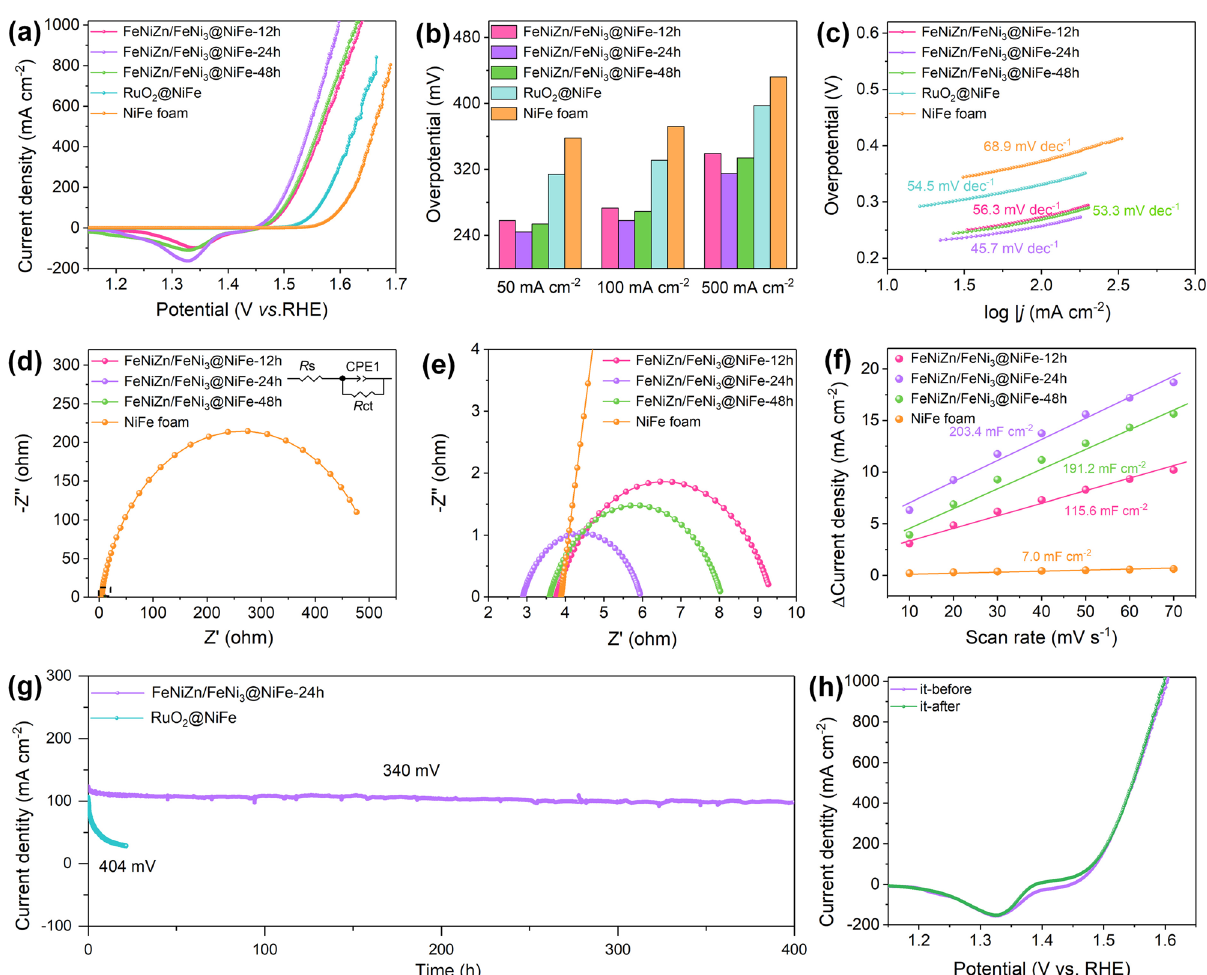
Fig. 5 a LSV curves of FeNiZn/FeNi 3 @NiFe samples, RuO 2 @NiFe, and NiFe foam in 1.0 M KOH solution at the scan rate of 5 mV s −1 . b Overpotentials of all electrodes at the 50, 100, and 500 mA cm −2 . c Tafel plots of all samples. d , e EIS data of FeNiZn/FeNi 3 @NiFe samples and NiFe foam. f The capacitive current at 1.05 V vs. RHE at different scan rates. g i–t curve under the overpotential of 340 and 404 mV for FeNiZn/ FeNi 3 @NiFe-24 h and RuO 2 @NiFe, respectively, and h LSV curves at a scan rate of 5 mV s −1 before and after i – t test for FeNiZn/FeNi 3 @NiFe- 24 h toward